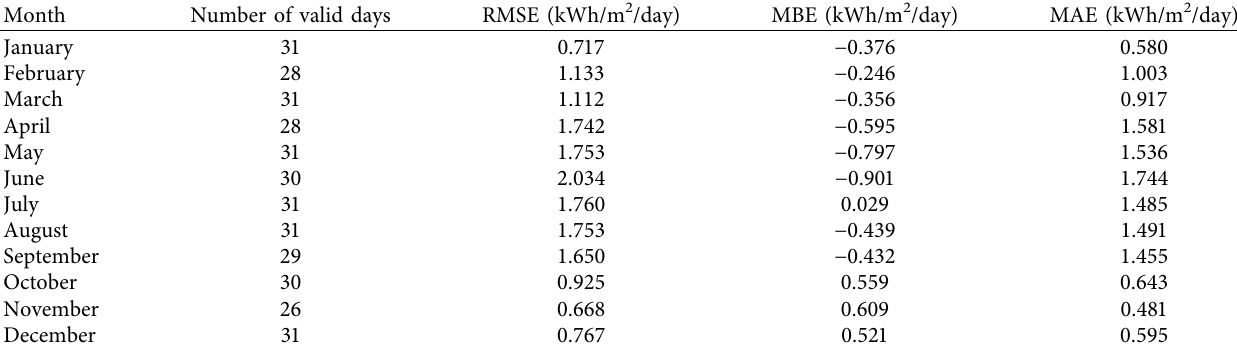
Table 7: Accuracies of the optimal predicted values as compared to the measured values.